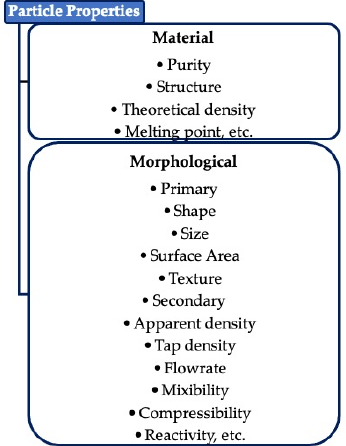
Figure 3. Categorization of particle properties (modified from [15]).